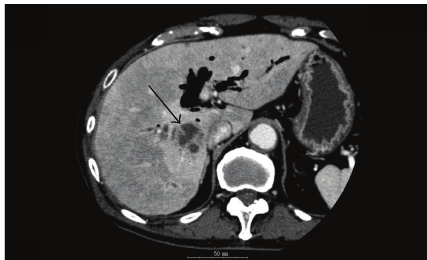
Figure 1: CT scan showing contrast-enhanced lesion in liver (arrow).